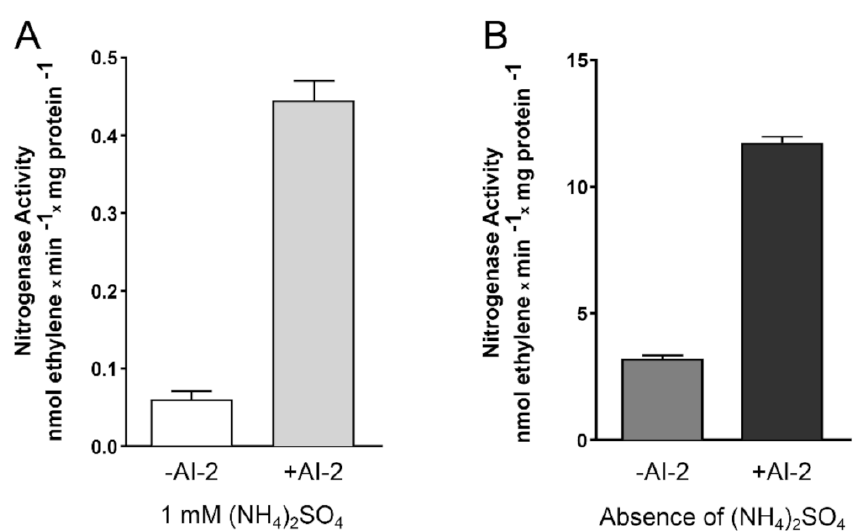
Figure 5. Acetylene reduction assay (ARA) to measure nitrogenase activity in Z. mobilis , in response to the presence of AI-2. Z. mobilis cells were inoculated in semi-solid MM, either in the absence or in the presence of 45 µ M AI-2. After incubation for 48 h at 30 ◦ C, 1 mL of 10% acetylene was injected into the headspace of the flasks, which were incubated for another hour, at 30 ◦ C. The ethylene (C 2 H 4 ) formed inside the bottles (resulting from the action of bacterial nitrogenase) was then detected and quantified by gas chromatography. The cellular biomass present in each flask was estimated by total protein quantification and the nitrogenase activity expressed as nmols of C 2 H 4 produced/min/mg of protein. The experiments were carried out in triplicate and the graphs show the mean and SEMs obtained for each condition. The figure also compares the results obtained in an assay conducted in MM medium containing 1 mM (NH 4 ) 2 SO 4 ( A ) and a similar assay, conducted in MM lacking (NH 4 ) 2 SO 4 ( B ), since the presence of NH 4+ is known to inhibit nitrogenase activity